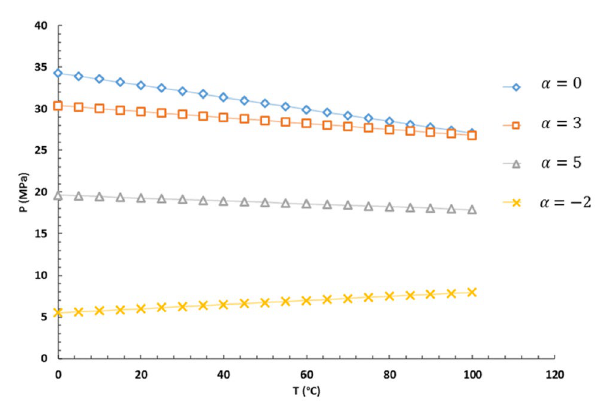
Fig. 15 Comparison of hoop stress and ultimate tensile strength for GFRP sleeve at various proportionality